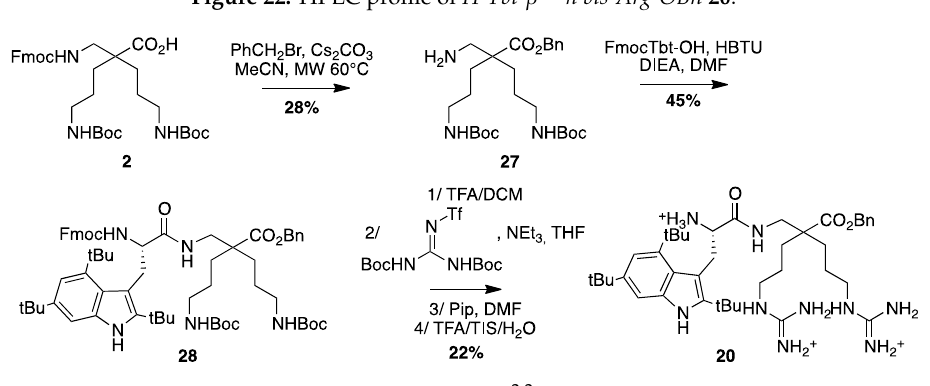
Figure 21 . HPLC profile of Np-Tbt- β 2,2 h bis-Orn-OMe 19